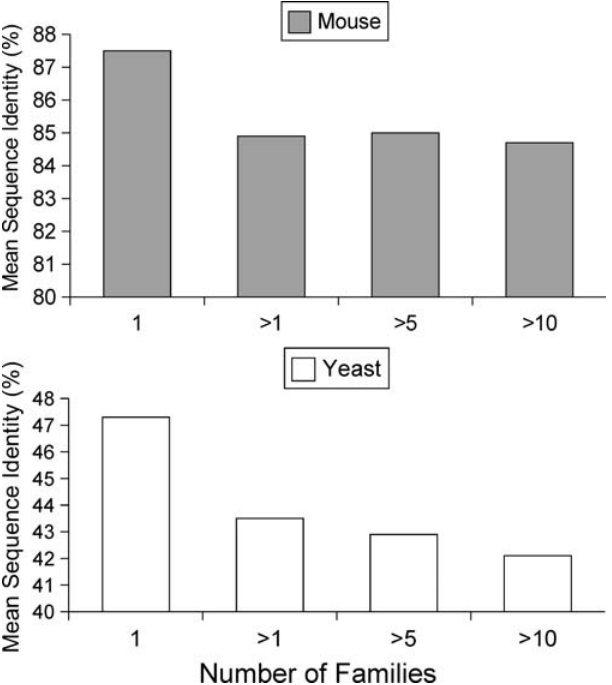
Figure 2. Sequence Divergence and Family Counts of Ancient Folds